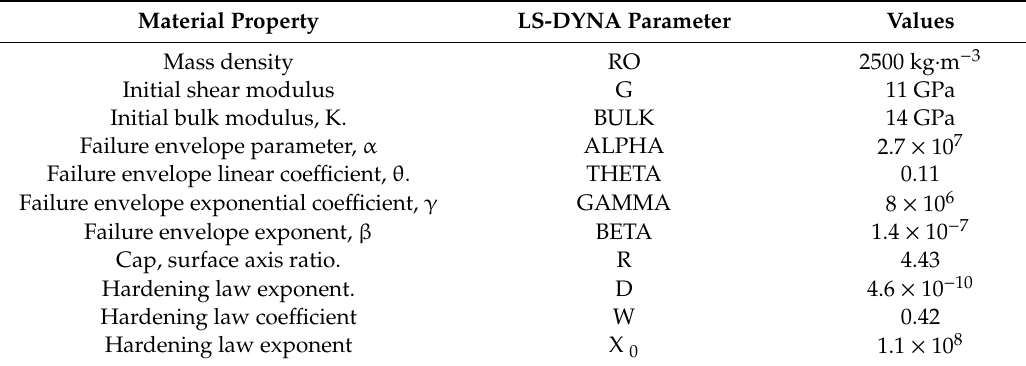
Figure 11. Finite element model of the pier with the meshed impact zone. Table 2. Concrete material parameters of the pier impact